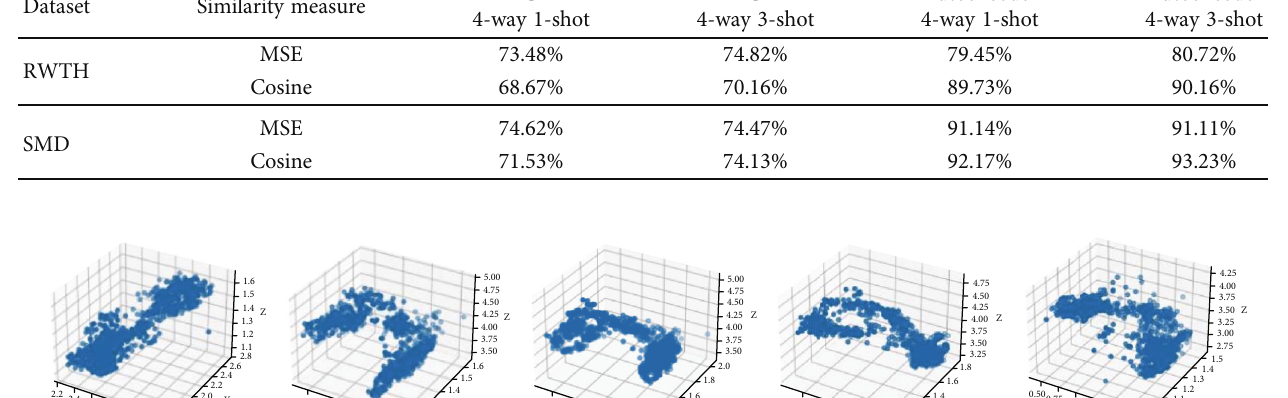
Table 4: In fl uence of linear and nonlinear dimensionality reduction methods on model recognition accuracy. Dataset